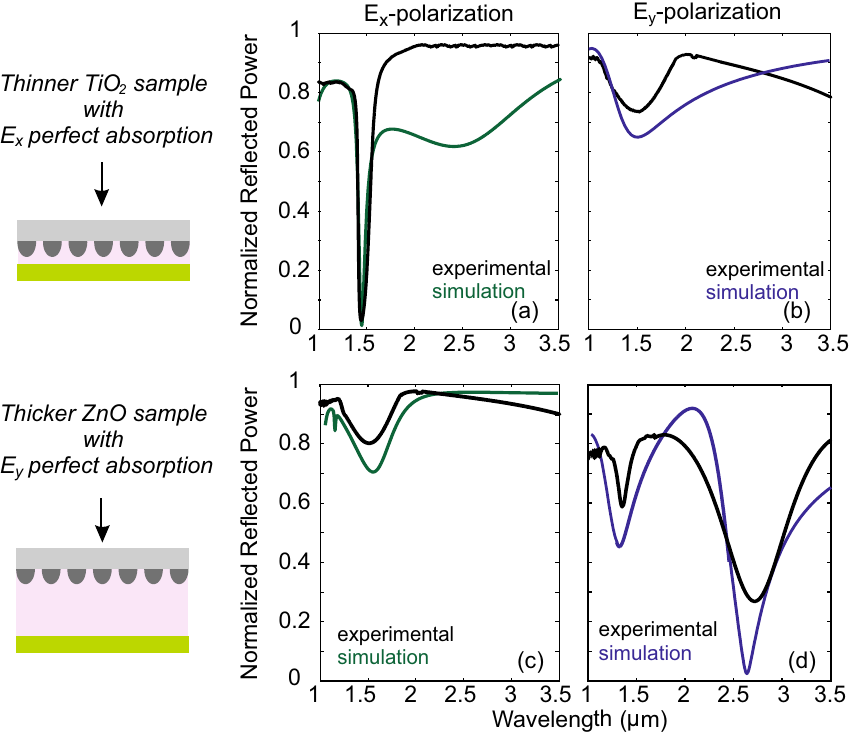
Figure 5. FTIR experimental measurement of the reflected power (black lines) for the two fabricated samples, the thinner TiO 2 cavity sample (top panels) and the thicker ZnO cavity sample (bottom panels) for the two polarizations, E = E x [( a ) and ( c )] and E = E y [( b ) and ( d )]. The measurements are corroborated by the corresponding simulation (green and blue